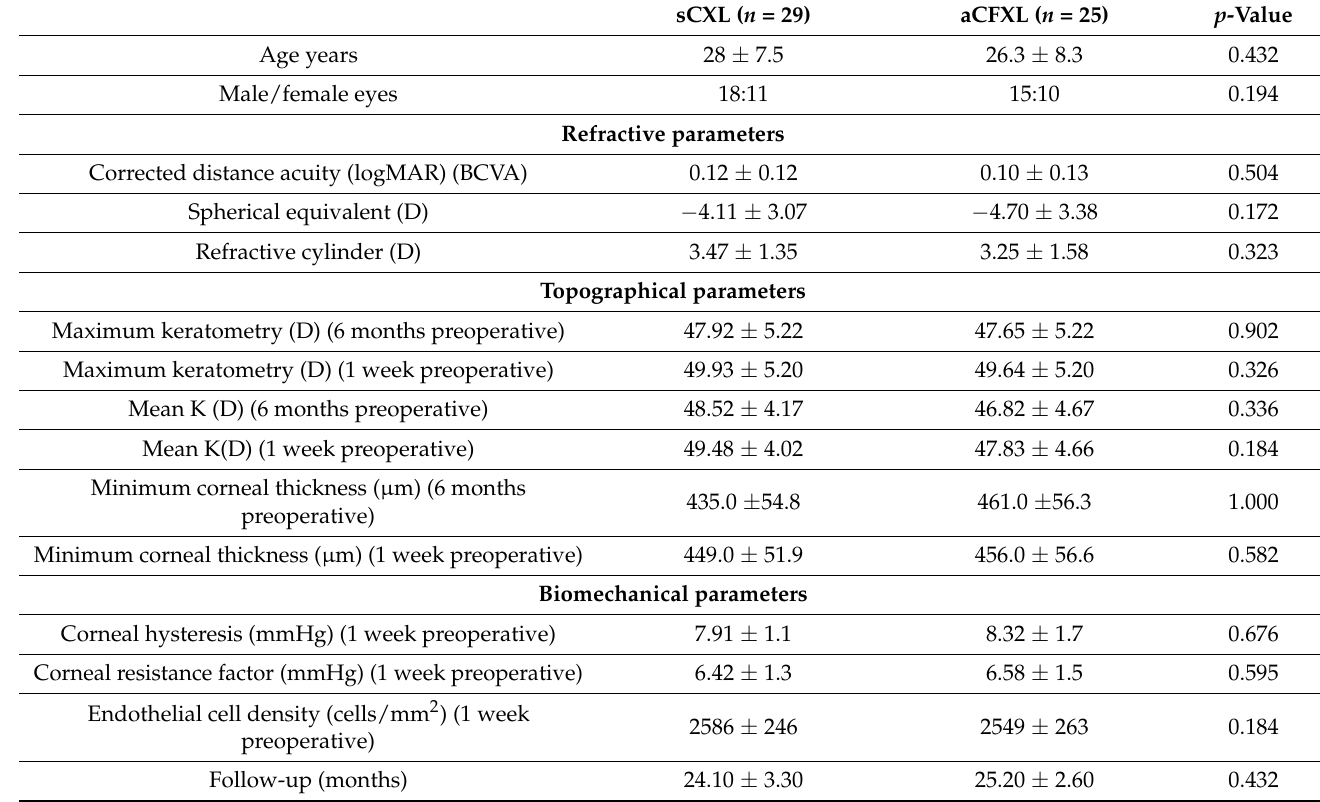
Table 2. Comparison of baseline parameters in the sCXL and aCFXL